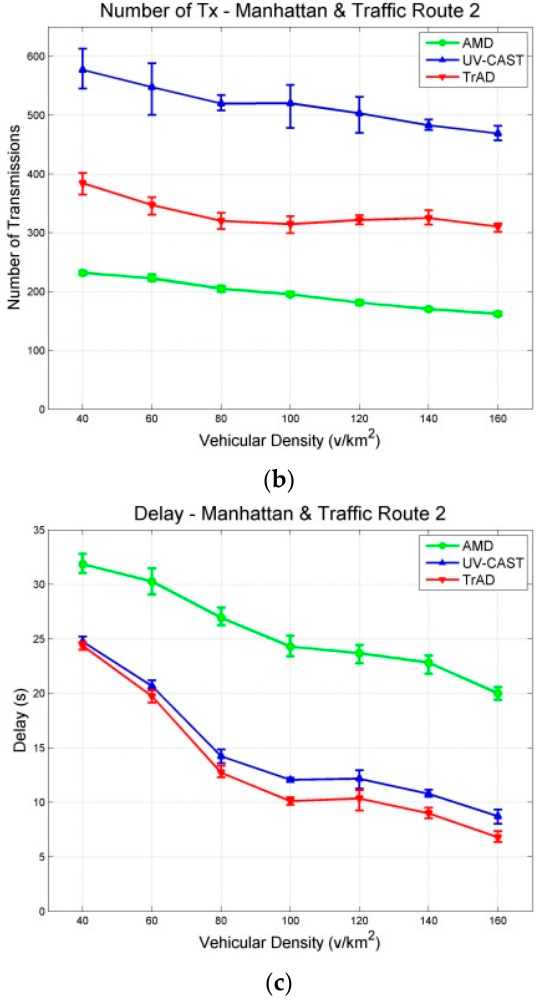
Figure 10. Results with a 95% confidence interval in Manhattan scenarios with the traffic route 2 (deviated): ( a ) PDR; ( b ) Number of Transmissions; ( c ) Delay.